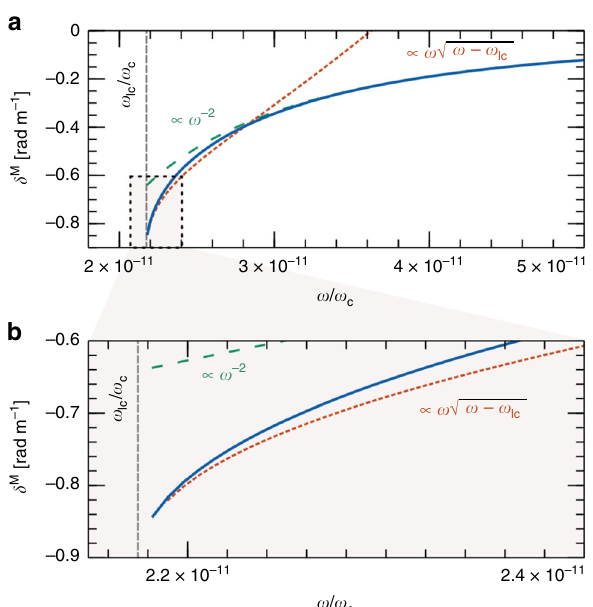
Fig. 3 Mechanical polarisation rotation footprint near and above the frequency cut-off. In panel ( a ), RM ISM = 5 (in solid black) corresponds to the classical λ 2 Faraday rotation of the polarisation angle (PA) due to the propagation in the ISM, while the orange triangles show the deviation from the ISM Faraday rotation due to MOR in the rotating magnetosphere computed for the canonical normal pulsar parameters given in Table 1 and h ¼ 10 r Ω > 0). Panel ( b ) shows in solid purple the aggregate RM (cid:2) ( em corresponding to RM ISM + RM MOR , while the horizontal dashed-dotted grey line illustrates the frequency independent RM predicted for ω (cid:4) ω